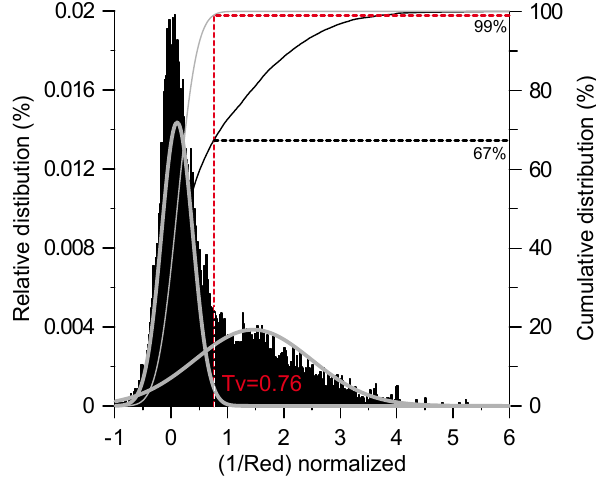
Fig. 4b. Gaussian mixture model of the normalised red colour data (Fig. 3a) used to disentangle two overlapping sub-distributions and to identify the upper limit of the main distribution (threshold